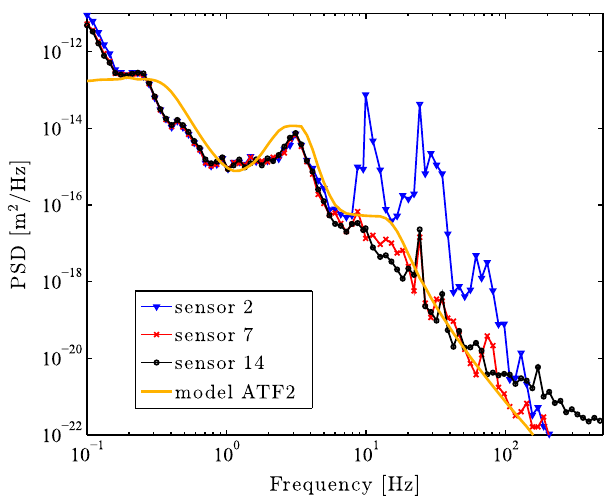
FIG. 11. Correlation spectra of the ground motion sensor 1 with other sensors ’ measurements in vertical direction. The measure- ments are compared with model